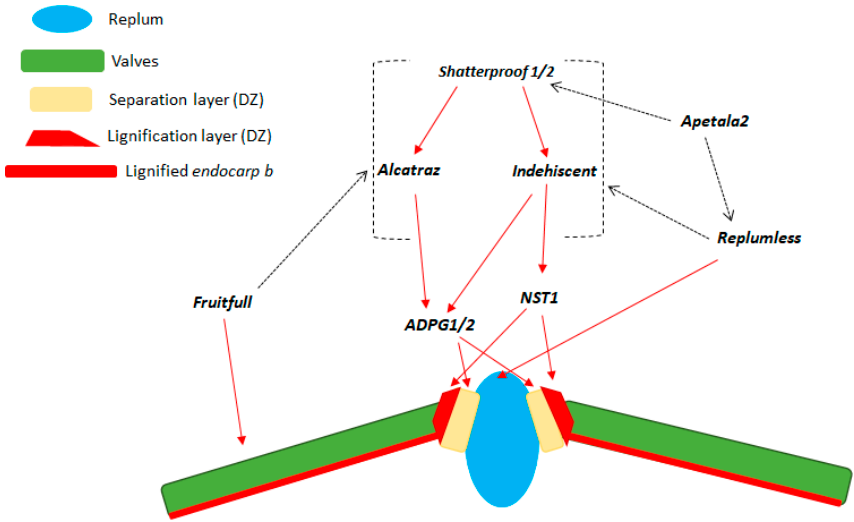
Figure 7. Illustration of model of the genetic cascade underlying differentiation of the dehiscence zone (DZ) and silique shattering in A. thaliana . Transverse section of the fruit is shown. Red arrows, positive gene regulation; black dashed arrows, negative gene regulation; square brackets, negative regulation on more than one gene (reproduced with permission from Dong and Wang [38]; with modifications).